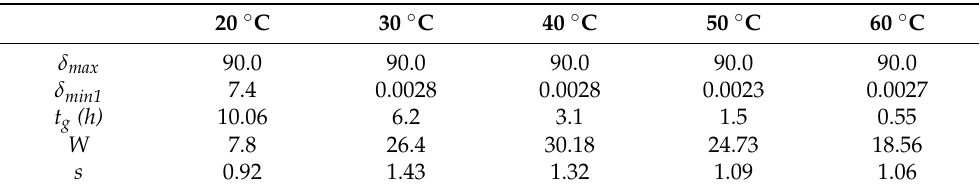
Table 1. The parameters of the five-parameter logistic model (Equation (1)) for the gelation process at different